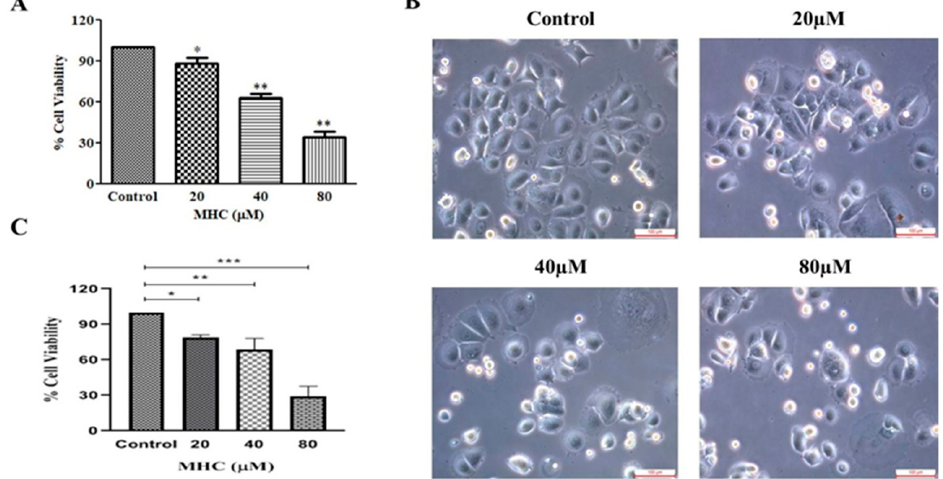
Figure 3. Anti-cancer effect of MHC against MCF-7 cells: ( A ) cellular viability post-MHC treatment after 24 h, ( B ) photomicrographs indicating the morphological alterations and ( C ) cell viability % of MDA-MB-231 in response to MHC exposure. Scale bar 100 µm. * p < 0.05, ** p < 0.01 and *** p < 0.001.